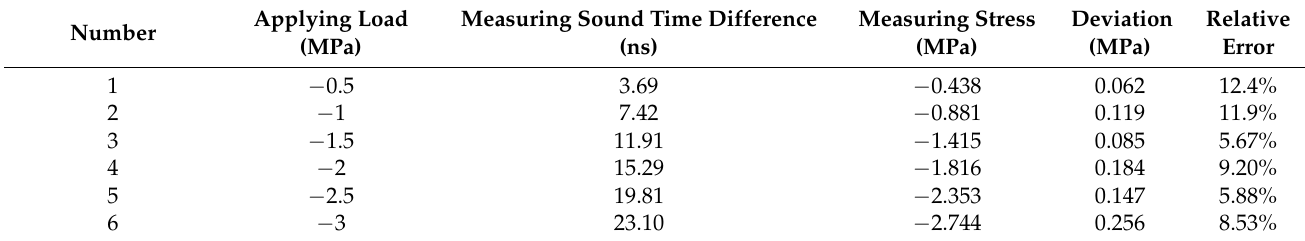
Figure 20. PBX pressure-sound time difference curve. Table 5. Pressing PBX sample deviation of measurements.